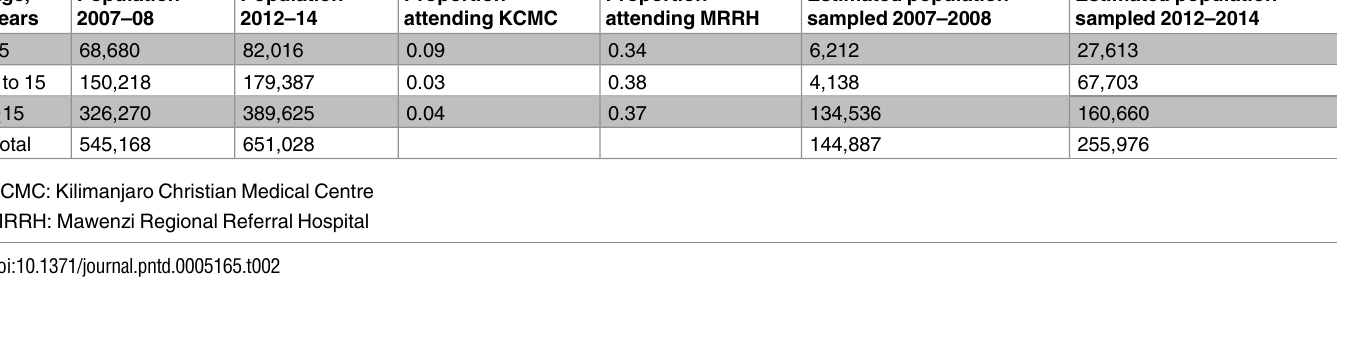
Table 2. Estimated population of Moshi Urban and Moshi Rural District that reported that they would attend KCMC or MRRH if they developed a febrile illness during the time periods 2007–08and 2012–14. Age,